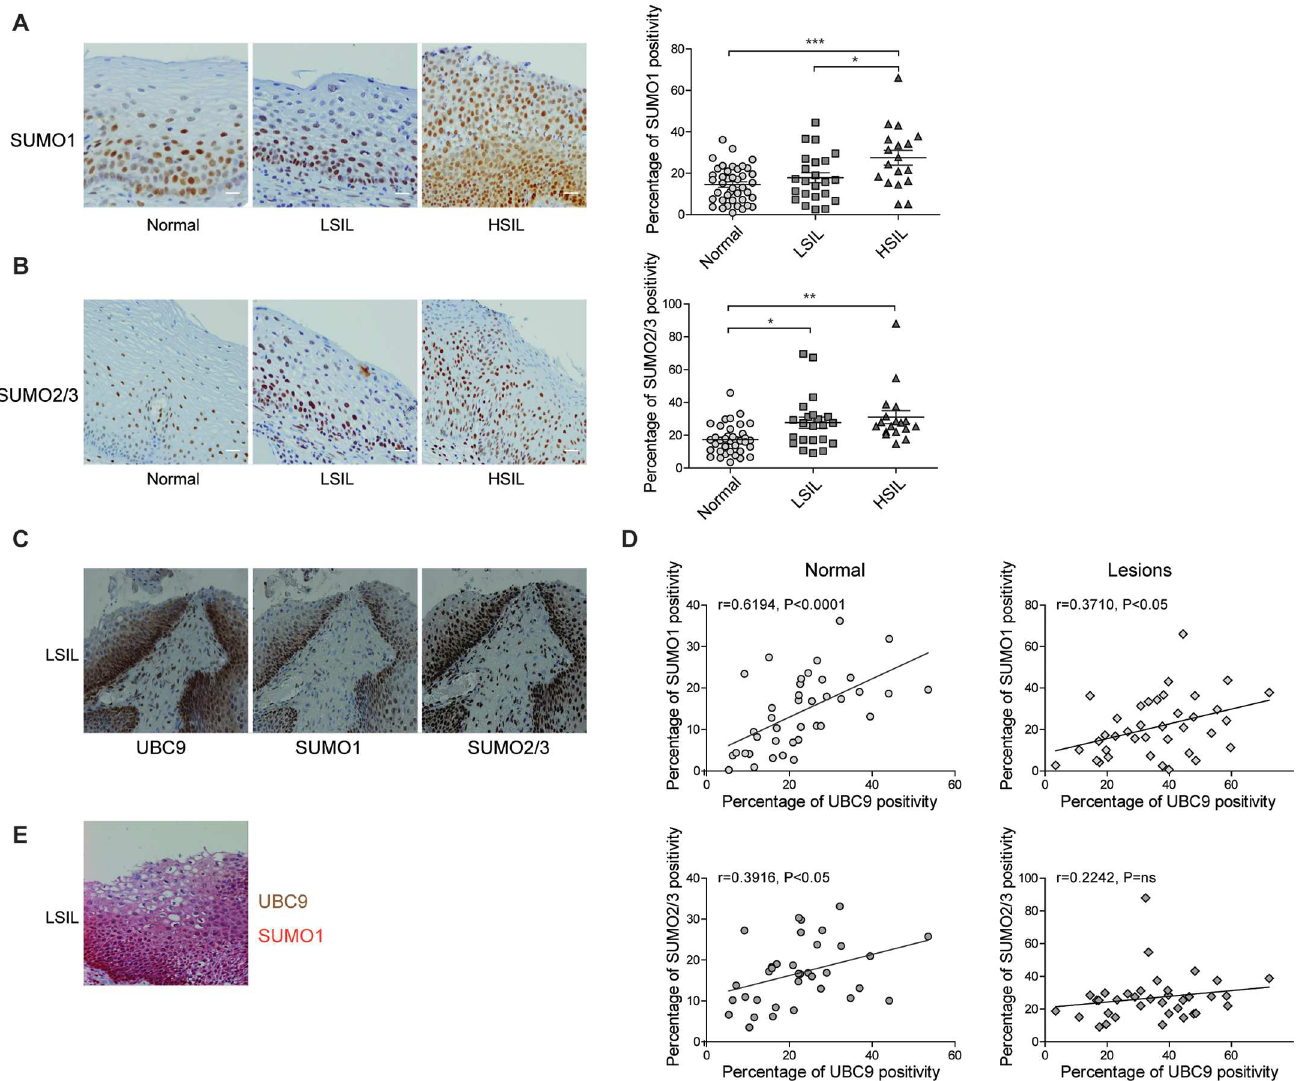
Fig 3. UBC9 preferentially promotes SUMO1 conjugation ex vivo . (A) and (B) Left: Representative IHC images of FFPE human normal, LSIL or HSIL cervical tissues stainedwith anti-SUMO1 or anti-SUMO2/3 antibodies, respectively.Right: Percentage of SUMO1-, or SUMO2/3-positive pixels, respectively, in FFPE humancervical tissues. Scale bars = 200nm. Data are expressedas percentage of positive plus strong positive stainedpixels. The black lines represent the mean for each group. n = 37 (normal), 20 (LSIL), 20 (HSIL) different patients. * P < 0.05; ** P < 0.001; *** P < 0.0001(one- way ANOVA followedby Bonferroni post hoc test). (C) Representative IHC images of a FFPE human cervical tissue stainedwith anti-UBC9,anti- SUMO1 or anti-SUMO2/3 antibodies, respectively. (D) Top: Correlation between UBC9 and SUMO1 expressionin paired normal(left) or lesion(right) tissues. n = 39 (normal), 38 (lesions) respectively.Bottom: Correlation betweenUBC9 and SUMO2/3 expressionin pairednormal (left) or lesion (right) tissues. n = 41 (normal), 38 (lesions) respectively.Spearmanrank correlationwas appliedto analyze association betweenvariables. Scattered plots with linear regressionlines, Spearmanr correlationcoefficient,and p value are reported. (E) Representative IHC images of a FFPE humancervical tissue co-stainedwith anti-UBC9(brown) and anti-SUMO1 (red). Note that almost all cells were both UBC9 and SUMO1